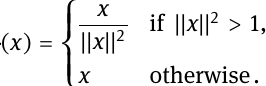
Figure 2: Example 4.1, Experiment 2, top